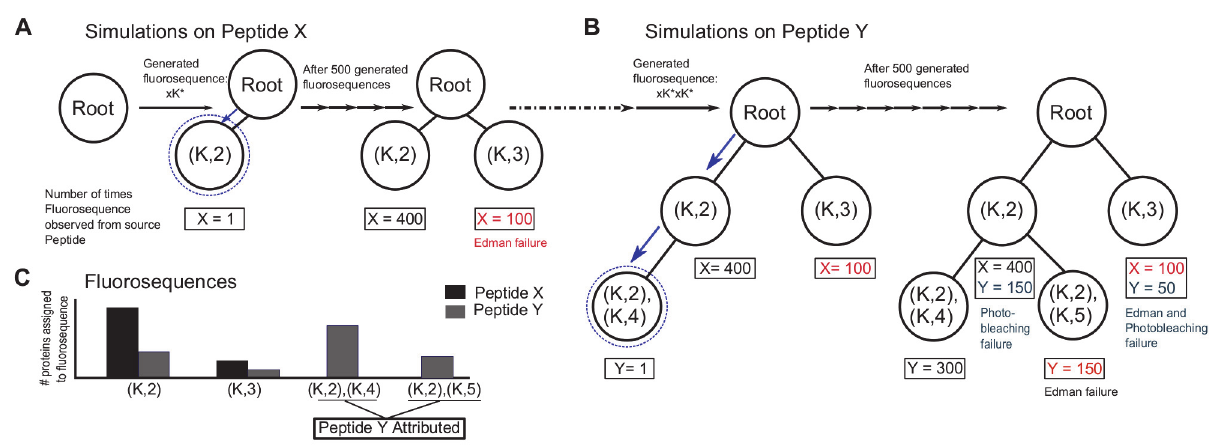
Fig 5. A simple example of the trie structure for storing and attributing fluorosequences to peptides or proteins. Consider a toy peptide mixture with peptide X (sequence GK * EGC, where K * represents fluorescently-labeled lysine; the sequence can be simplified to (K,2)) and peptide Y (GK * GK * EC; represented as (K,2),(K,4)). Panels (A) and (B) summarize populating the trie with fluorosequences from 500 copies each of Peptide X and Y, respectively. For example, peptide X might generate fluorosequence xK * , incorporated into the trie as a new node (K,2), indicated by the dashed blue lines and arrows in panel (A). (B) Simulations on Peptide Y add additional nodes to the trie. For example, the fluorosequence xK * xK * yields an additional node (K,2),(K,4) after traversing node (K,2). Additional fluorosequences are incorporated into the trie in a similar fashion, along with a tally of the number of observations of each fluorosequence, stored for each trie node along with the source peptide identities. Following the Monte Carlo simulation, the frequency of each source protein or peptide can be calculated for each trie node. To simplify data analysis and visualization, thresholds can be applied (see Methods ) to identify and count those source proteins most confidently identified by the observed fluorosequences. Here, fluorosequences ((K,2),(K,5)) and ((K,2),(K,4)) confidently identify peptide Y, while Peptide X is less confidently identified by fluorosequences (K,2) or (K,3).